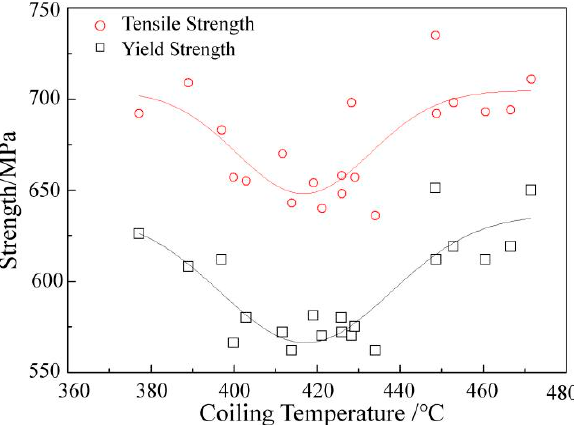
Figure 7. The relationship between the material strength and the coiling temperature.